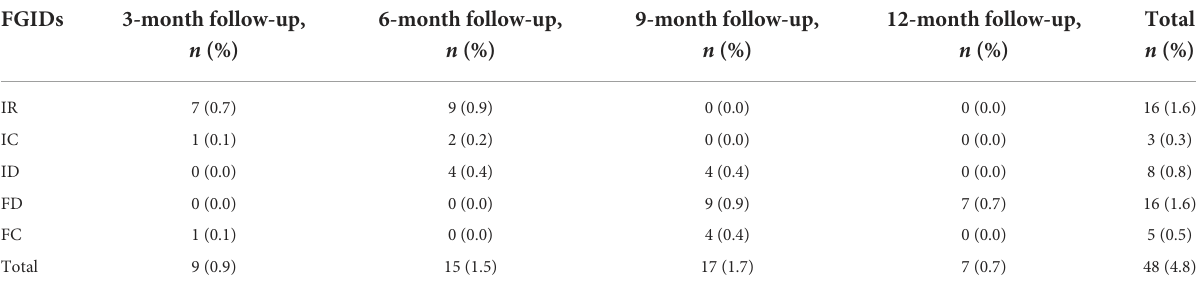
TABLE 1 Infant FGIDs diagnosis modification rate during regular follow-up visits.